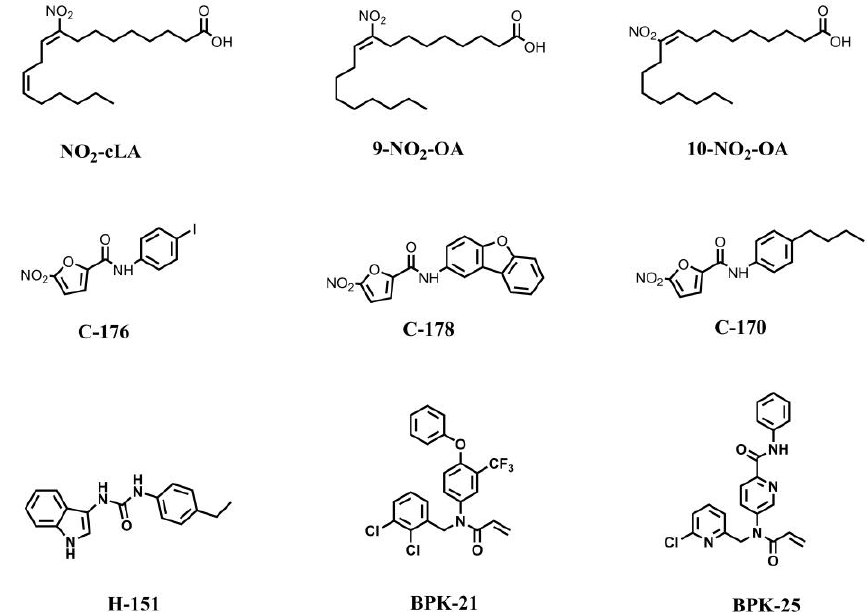
Figure 4. STING inhibitors targeting palmitoylation sites.